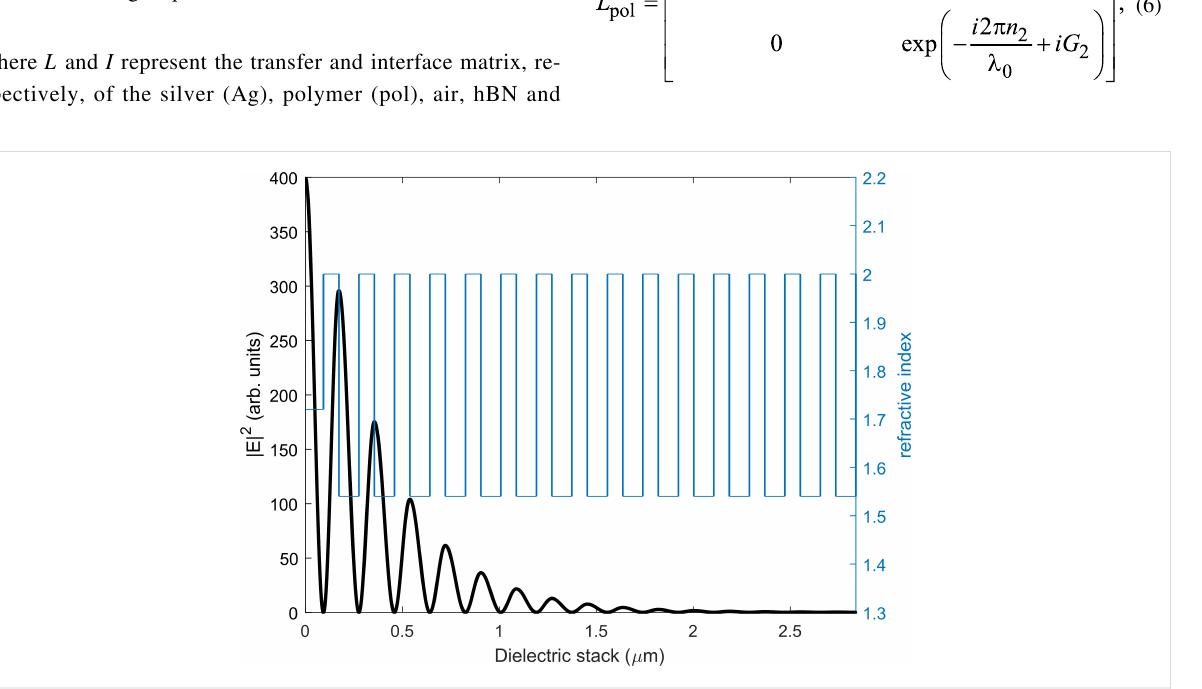
Figure 6: Electric field distribution of a hBN + DBR system on a L ( HL ) 15 configuration. Maximum electric field intensity is found at the surface of the hBN layer. Vertical lines (blue) represent the boundaries between each dielectric layer.